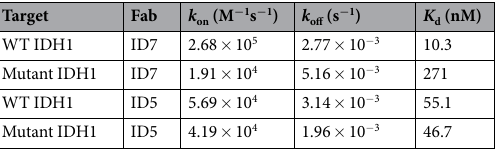
Table 2. Thermodynamic and kinetic parameters for the interactions between Fabs ID7 and ID5 with the WT and mutant IDH1.